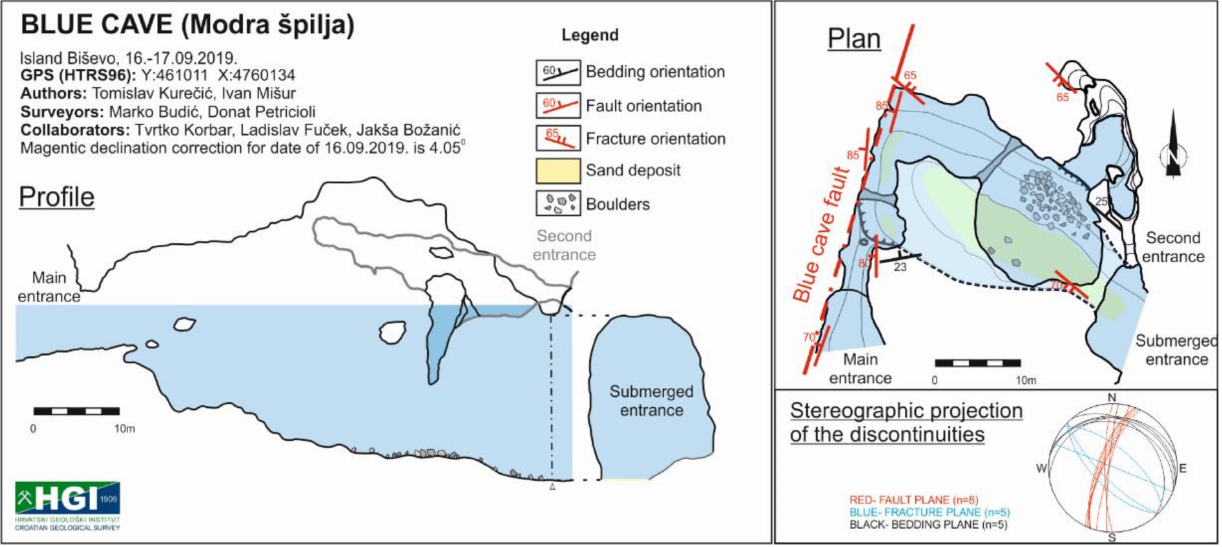
Figure 4. Plan and profile of the Blue Cave (Modra špilja) (cave symbols according to [23,24]), with marked orientations of the fault planes, fractures, and bedding planes. Stereographic projection (bottom right) of all measured discontinuities on the surfaces and in the cave (lower-hemisphere